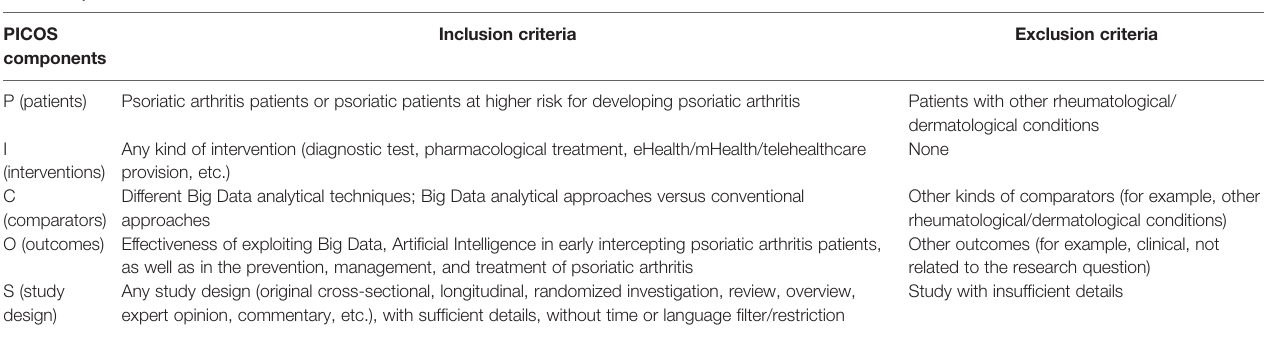
TABLE 1 | Inclusion and exclusion